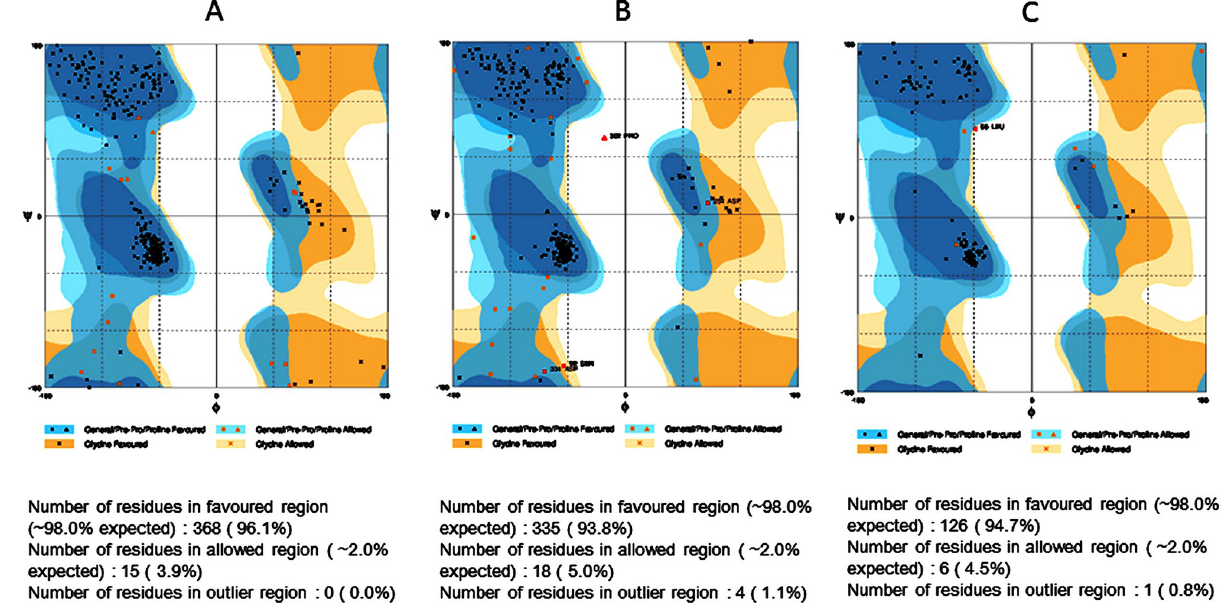
Fig 7. RAMPAGE analysis of nrtACD proteins. Values indicate number of the residues in favored, allowed, and outlier region. (A) nrtA, (B) nrtC and (C) nrtD.